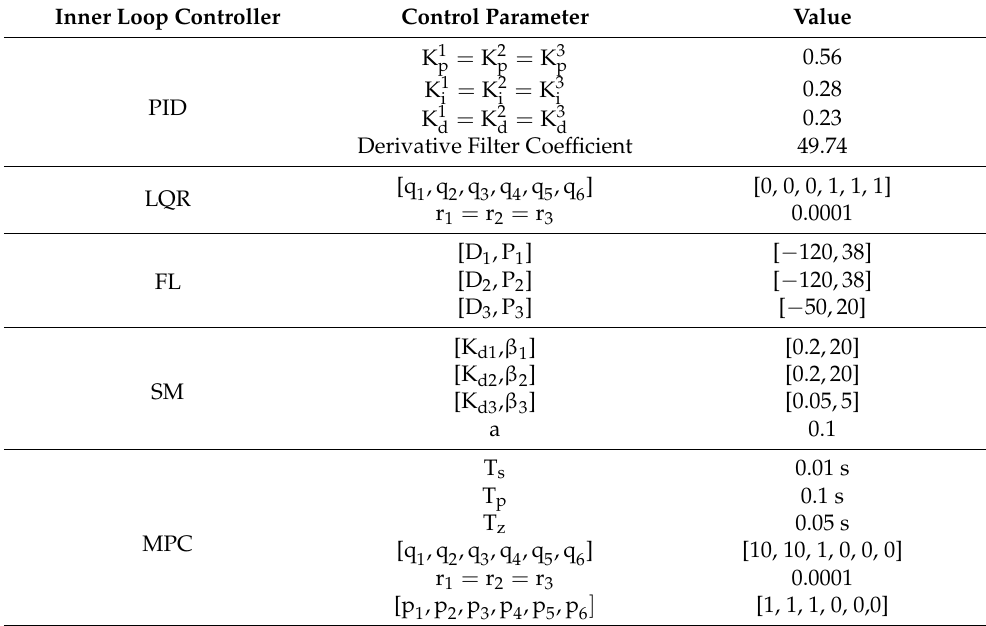
Table 2. Attitude stabilization controllers’